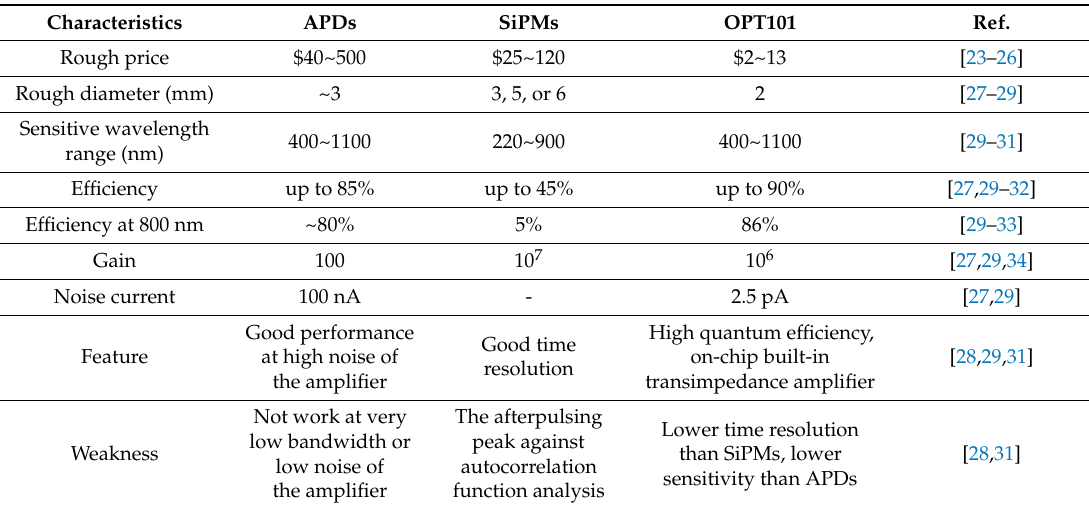
Table 1. Comparison of OPT101 and other optoelectronic sensors in near-infrared spectroscopy (NIRS)